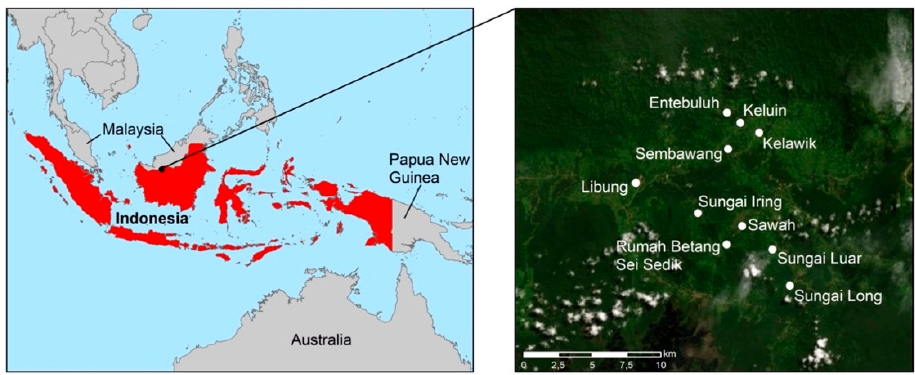
Figure 1. Study area. Source: own illustration based on Geographic Information System (GIS) data.